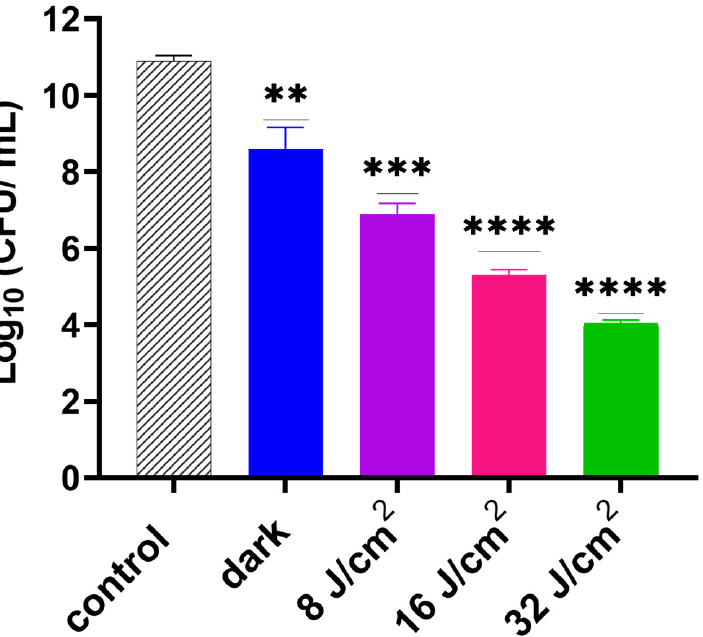
Figure 4. Viability of S. aureus biofilms following activation of GaPP-LCNP 15 µM using different light doses of blue light at 405 nm (8–32 J/cm 2 ) compared to the negative control in the dark. Data plotted as mean ± SD, n = 3. ** significant reduction p = 0.0018, *** p = 0.0001, **** p <0.0001. (one-way ANOVA test followed by multiple comparison Dunnett’s test).